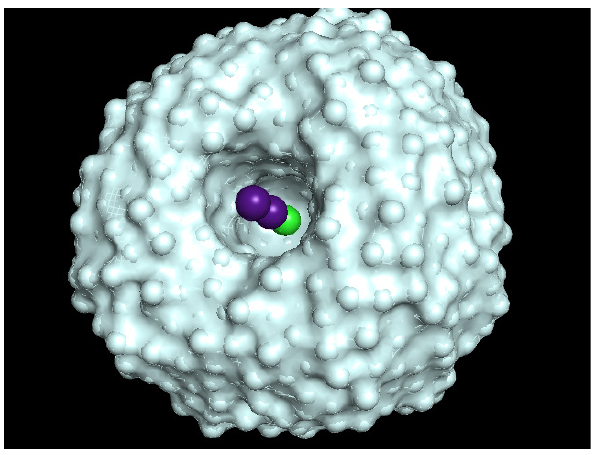
Figure 11. Structure of Cs 2 -C 60 @He 2090 system at 40 ps from a simulation with M = 10 and v 0 = 239.8